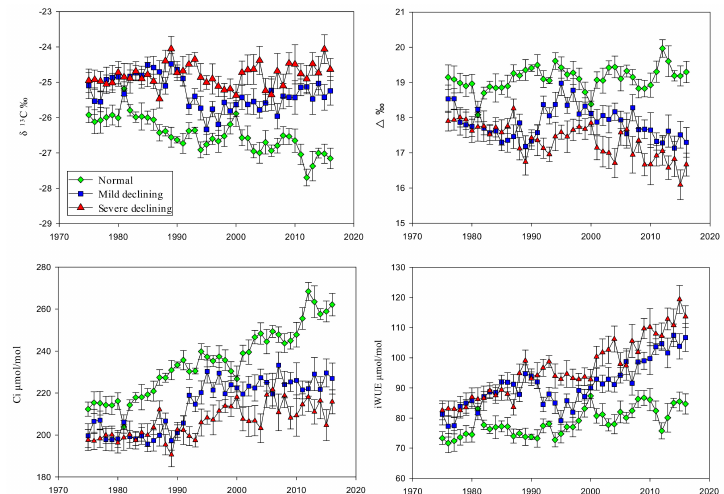
Figure 2. Annual variations of normal, mild declining and severe declining P. simonii in: the tree-ring cellulose stable carbon isotope ( δ 13 C; ( a )), tree-ring cellulose stable carbon discrimination ( ∆ 13 C; ( b )), intercellular CO 2 mole fractions (C i ; ( c )) and the intrinsic water-use e ffi ciency (iWUE; ( d )) between 1977 and 2016. Error bars indicate the standard error (SE) of the mean values.